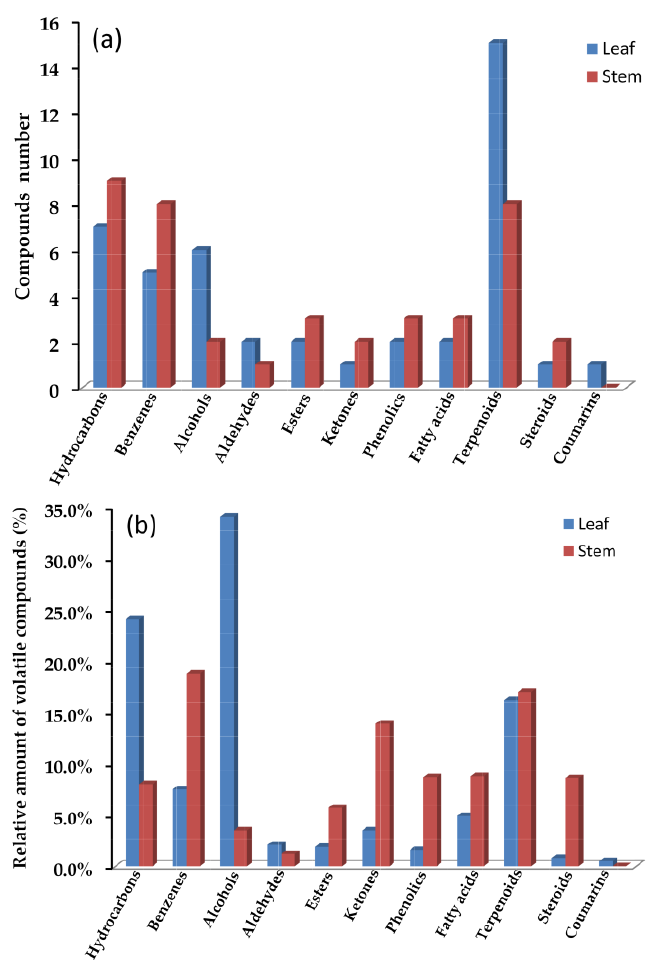
Figure 2. Comparison of volatile compounds from leaf and stem oils in F. japonicum : compounds number ( a ) and relative amounts of volatile compounds (%) ( b ).